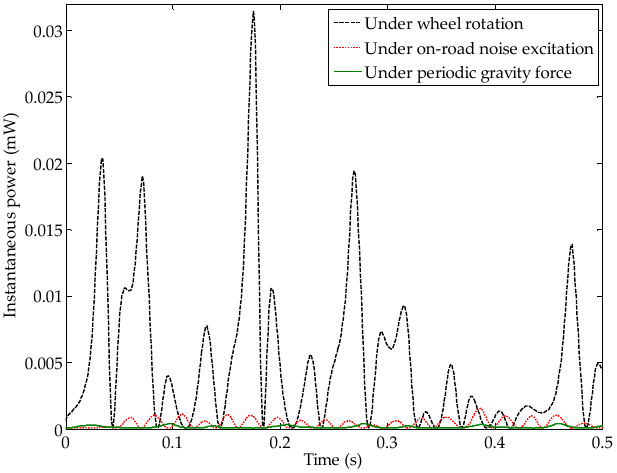
Figure 12. Comparison of the available net power under three conditions.